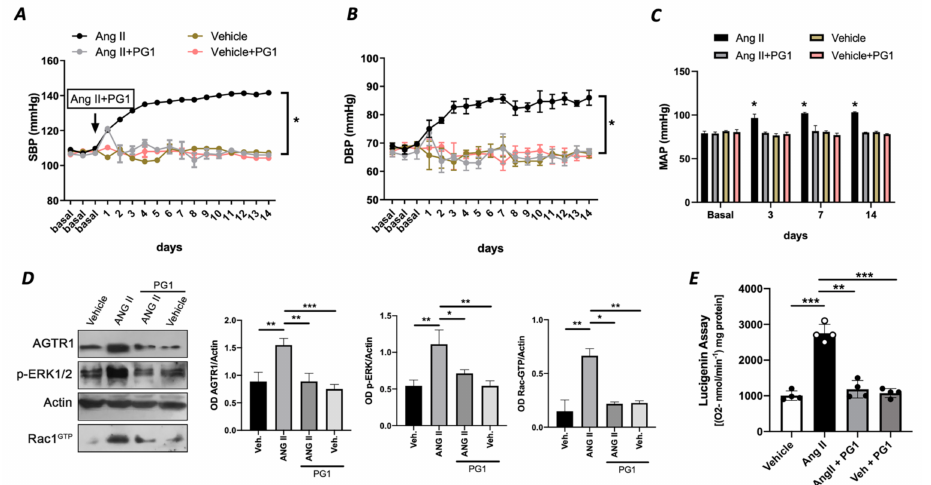
Figure 3. ( A ) Systolic blood pressure (SBP) and ( B ) diastolic blood pressure (DBP) and ( C ) mean arterial pressure (MAP) measured by tail-cuff method in wild-type mice daily treated with i.p injection of vehicle or PG1 (10 mg/Kg), or in wild-type angiotensin (Ang) II-infused mice daily treated with gavage administration of vehicle or PG1 (10 mg/Kg) mice. Values are means ± SEM. ( D ) Representative immunoblots conducted on extracts of mesenteric arteries excised at the end of in vivo (14th day) treatment from wild-type mice daily treated with gavage administration of vehicle or PG1 (10 mg/Kg), or in wild-type angiotensin (Ang) II-infused mice daily treated with gavage administration of vehicle or PG1 (10 mg/Kg) mice. ( E ) Oxidative stress measured by lucigenin assay in mice mesenteric arteries obtained at the end of in vivo treatment. *, p < 0.05; **, p < 0.001; ***, p <